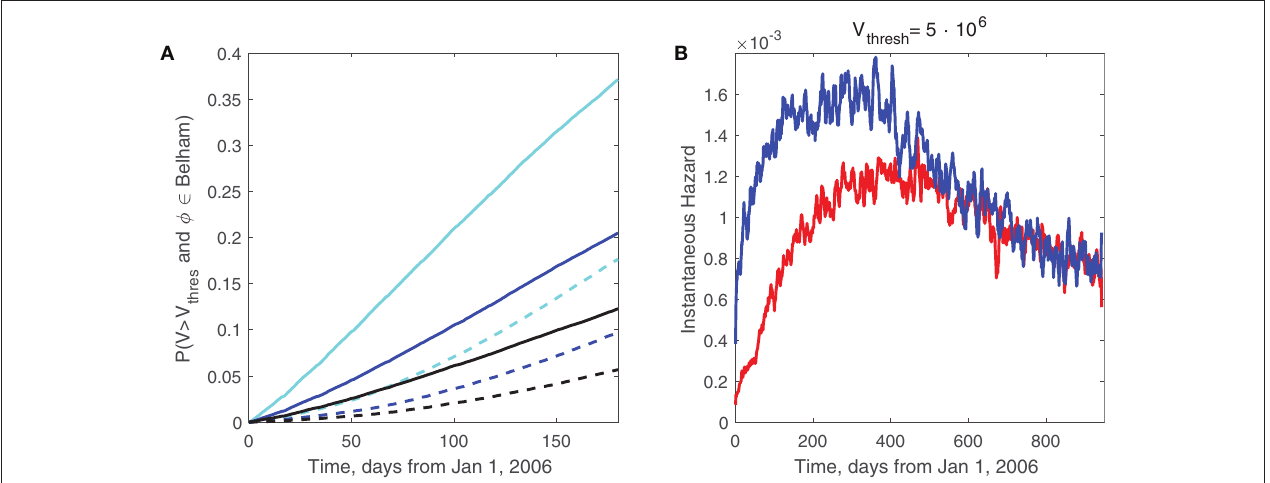
FIGURE 15 | (A) forecast probability of a PDC inundating the Belham Valley with a volume exceeding threshold V thresh in first t days following 1 st January 2006, vs. t , for a dome facing the Tar valley (due East, µ 0 0 ◦ , typical for SHV dome in 2000), as dashed curves; and for a dome facing the Belham Valley (Northwest, = µ 0 135 ◦ , typical for 2018), as solid curves. Threshold volume V thresh is 2 10 6 m 3 for cyan curves, 5 10 6 m 3 for blue curves, and 10 10 6 m 3 for black curves. = · · · Forecasts are based only on data prior to 1 st January 2006. (B) forecast daily hazard of Belham inundation by a flow exceeding 5 10 6 m 3 for a longer period, for a · dome facing the Belham ( µ 0 135 ◦ ), as upper blue curve, and for a dome facing due East ( µ 0 0 ◦ ), as lower red curve. Note hazards differ strikingly for first 200 = = days but are indistinguishable after 600 days. Daily (or instantaneous) hazard is the probability of inundation on day t , conditional on having no earlier